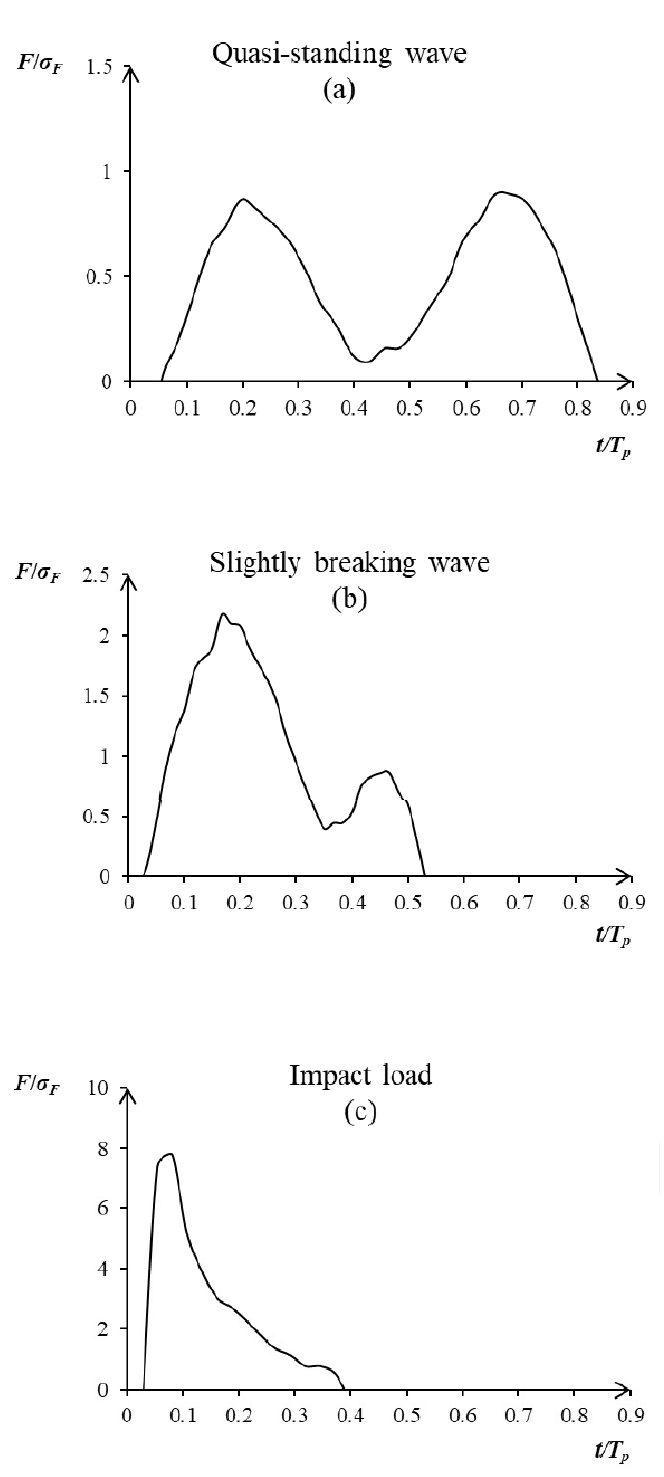
Figure 3. Example of the three conditions of wave loads F on the U-OWC breakwater versus time instant t (related to the peak period T p ): ( a ) a quasi-standing wave; ( b ) a slightly breaking wave F max / F 2 peak = 2.48 and ( c ) an impact load F max / F 2 peak = 10.18, recorded at